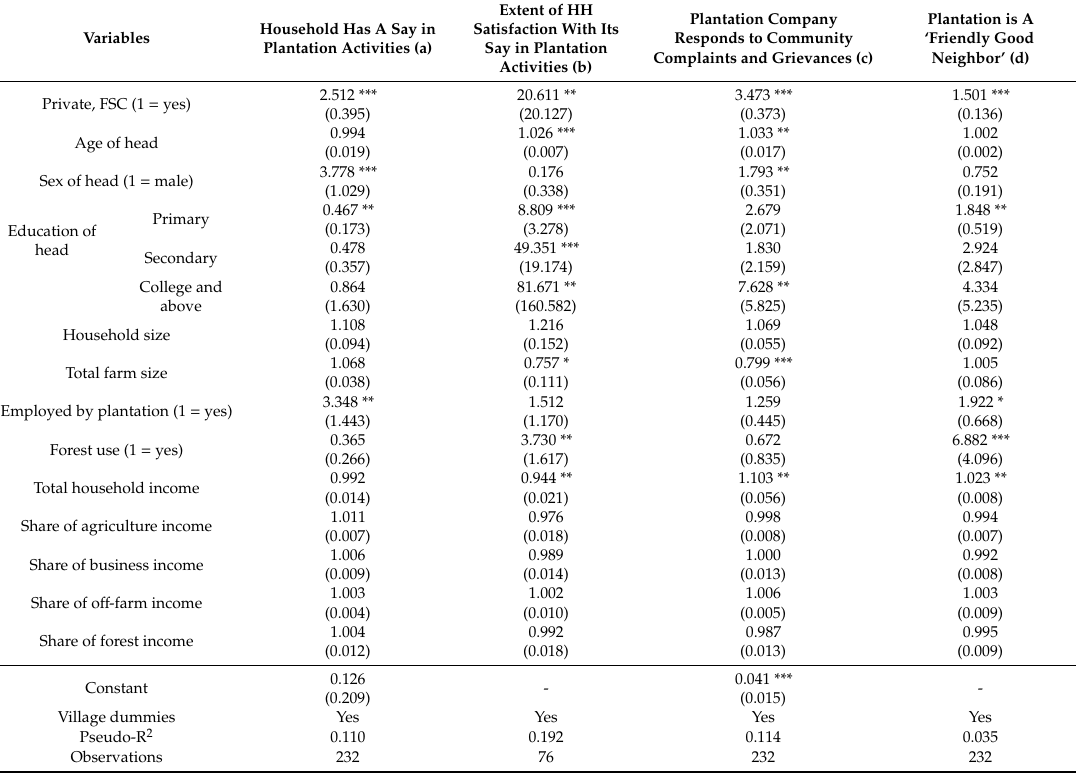
Table A3. Odds Ratios of Estimated Logit Models using the Observations for which Responses are Non-missing across the Four